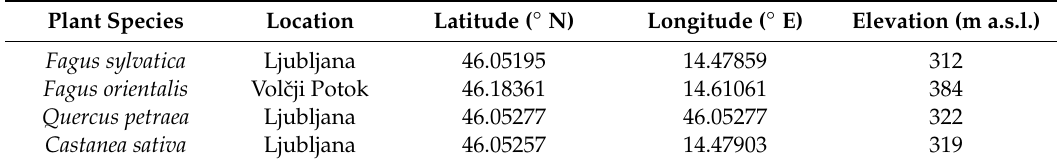
Table 1. Locations of samples collected for pathogenicity